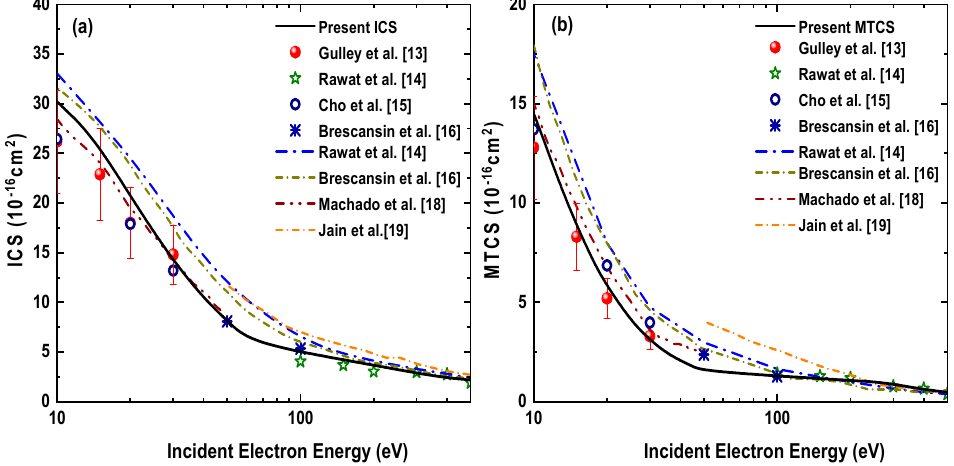
Figure 5. ( a ) Integrated cross sections and ( b ) momentum transfer cross sections for electron − H 2 S elastic scattering as a function of incident electron energy.